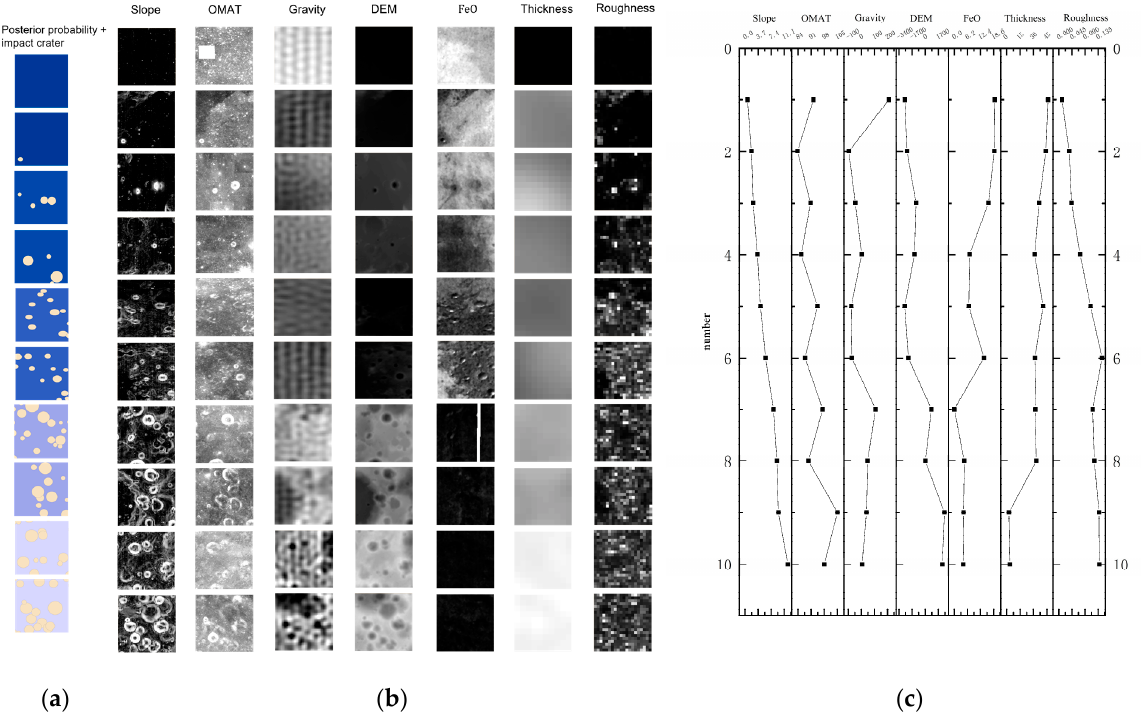
Figure 5. The distribution and statistical law of impact craters in 10 cells randomly selected from the whole moon. ( a ) The distribution of impact craters in 10 cells randomly selected in the whole moon and the change of the posterior probability (the background color is the posterior probability, the lighter the blue, the higher the posterior probability); ( b ) data for seven layers of evidence in 10 cells randomly selected across the moon; ( c ) quantitative line graph of the pixel mean of the data of seven layers of evidence in 10 cells randomly selected over the whole moon.